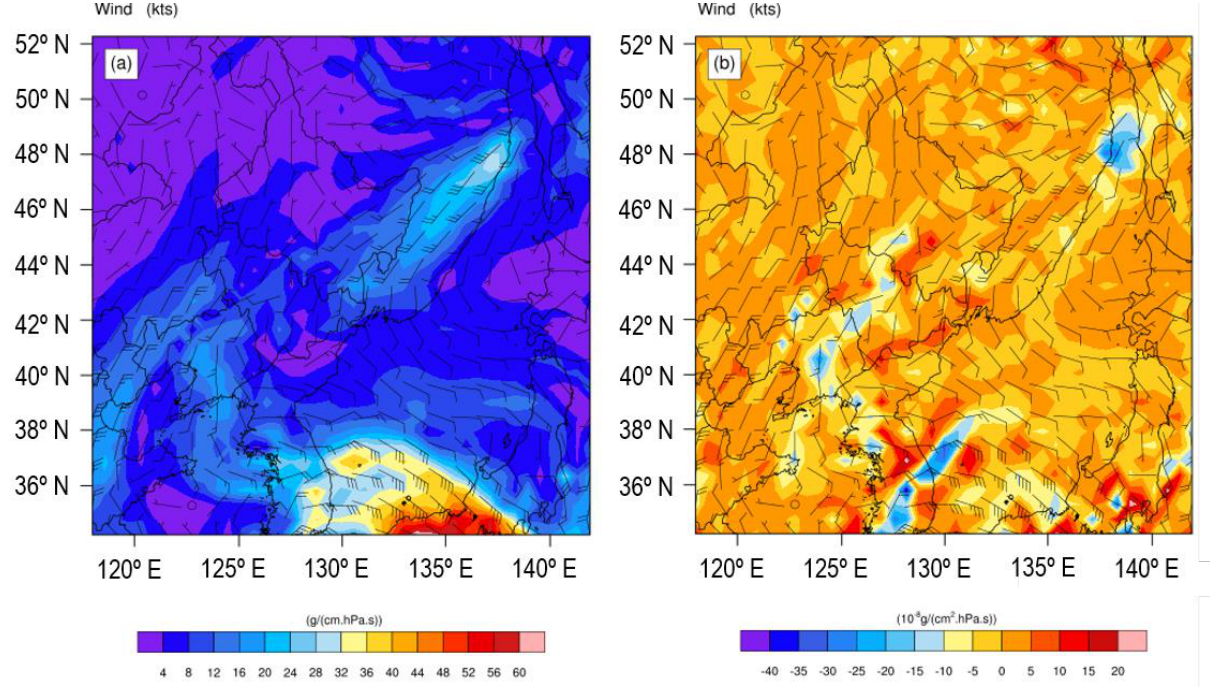
Figure 5. Horizontal winds (barbs;kts) and ( a ) vapor flux(shaded;g/(cm.hPa.s)); ( b ) water vapor flux divergence (shaded; 10 − 8 g/(cm 2 .hPa.s)) at 19 UTC on 14 August 2019.